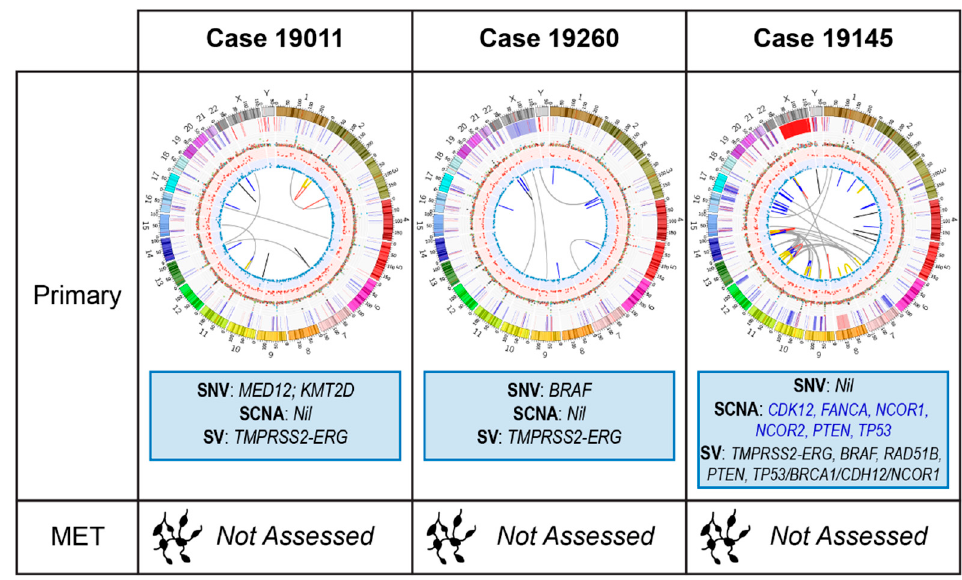
Figure 3. Summary of genomic alterations in primary prostate samples with synchronous lymph node metastases (Cases 19011, 19260 and 19145). Relevant somatic variants by type listed with SCNAs: blue indicates loss. Circos plots depict mutational load in each tumour sample. The outermost (first) track: autosome (chromosomes 1 to Y) ideograms with centromeres shown in red and the pter-qter orientation in a clockwise direction (length in Mbp); second track: somatic copy-number gains (red) and losses (blue); third track: somatic SNV allele frequencies (not corrected for tumour purity) coloured according to their mutation changes per Alexandrov et al. [39]; fourth and fifth tracks: allele frequencies (not corrected for tumour purity) of small deletions (red) and insertions (blue); innermost circle: acquired genomic rearrangements, including deletions (blue), tandem duplications (red), inversions (orange), insertions (black) and interchromosomal translocations (grey). MET: metastases.